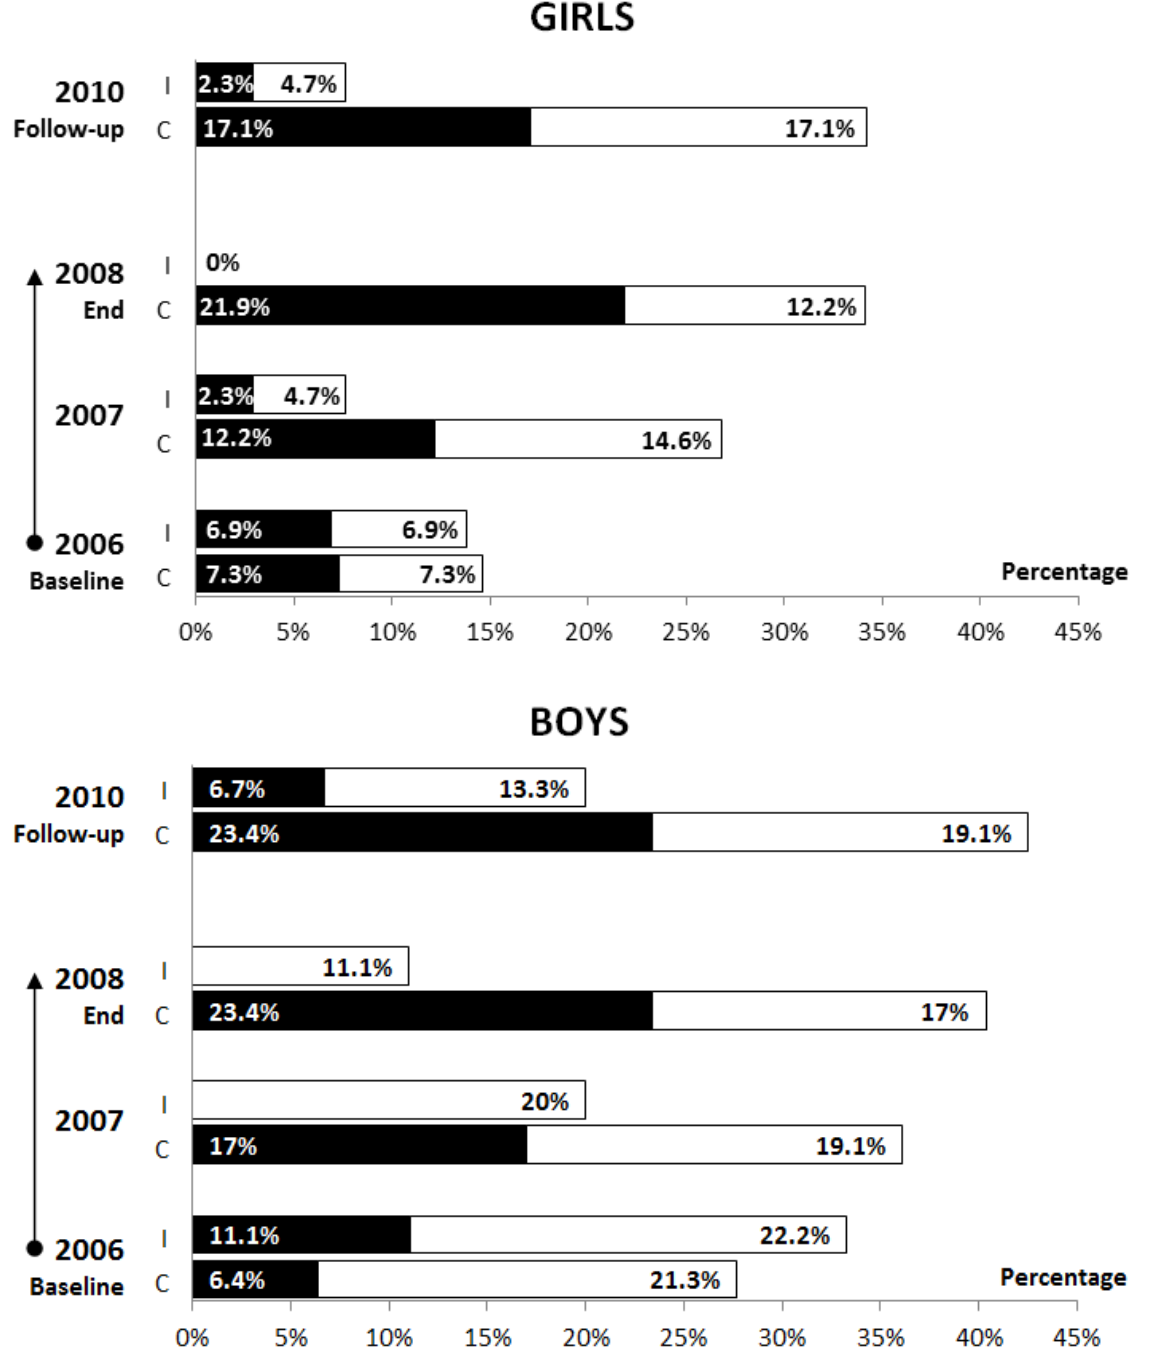
Figure 2. Mean percentages of obese and overweight intervention and control children throughout the intervention and follow-up ( ■ —obese; □ —overweight; I—intervention;